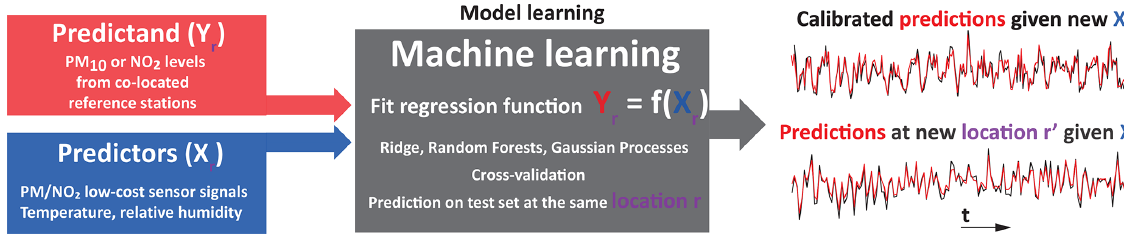
Figure 1. Sketch of the co-location calibration methodology. We co-locate several low-cost sensors for PM (for various particle sizes) and NO 2 with higher-cost reference measurement stations for PM 10 and NO 2 . The low-cost sensors also measure relative humidity and temperature as key environmental variables that can interfere with the sensor signals, and for NO 2 calibrations, we further include nitrogen oxide (NO) sensors. We formulate the calibration task as a regression problem in which the low-cost sensor signals and the environmental variables are the predictors ( X r ) and the reference station signal the predictand ( Y r ), both measured at the same location r . The time resolution is set to hourly averages to match publicly available reference data. We train separate calibration functions for each NO 2 and PM 10 sensor, and we compare three different machine learning algorithms (ridge, random forest and Gaussian process regressions) with multiple linear regression in terms of their respective calibration performances. The performance is evaluated on out-of-sample test data, i.e. on data not used during training. Once trained and cross-validated, we use these calibration functions to predict PM 10 and NO 2 concentrations given new low-cost measurements X , either measured at the same location r or at a new location r (cid:48) . The latter location is to test the feasibility and impacts of changing measurement sites post-calibration. The time series (right) are for illustration purposes